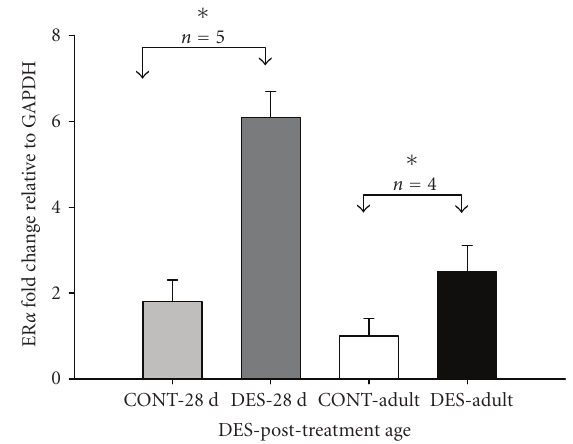
Figure 2: Real-time PCR showing 3.38 and 2.5 fold increase in ER α mRNA in penile tissue of 28-day-old (DES-28 d) and adult rats (DES-Adult) neonatally treated with DES, respectively. Fold change was calculated relative to respective controls (CONT-28 d and CONT-Adult). Data ( n = 4-5) are expressed as mean ± SE. ∗ P < . 05.